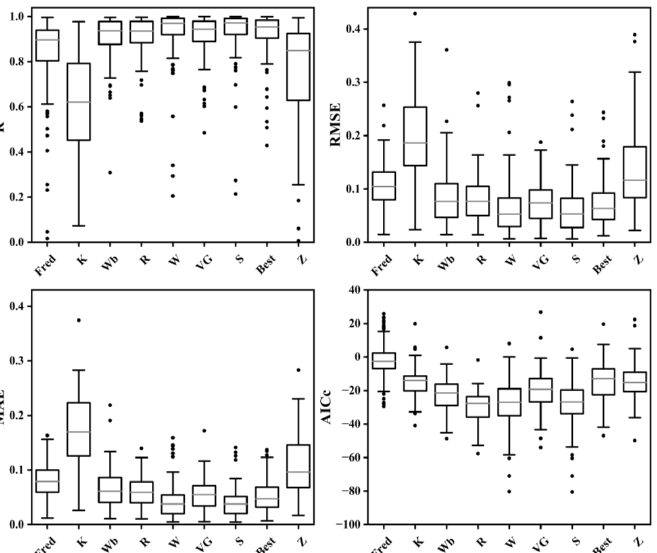
Figure 3. Box plots of the statistical criteria used to describe the accuracy of 9 models in fitting the cumulative particle size distribution data of 144 soil samples. The box plots show medians, inter- quartile ranges and